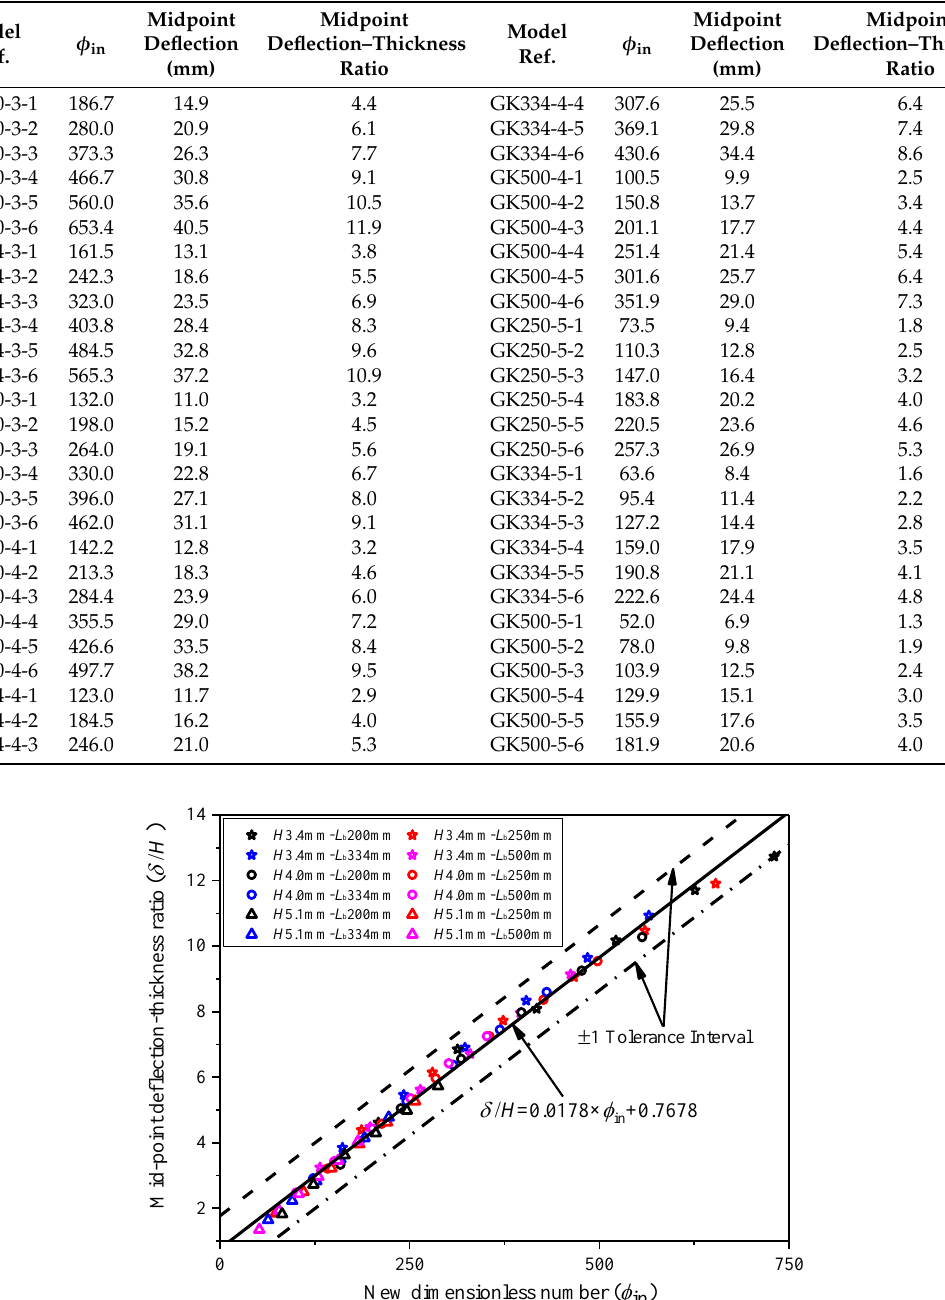
φ in  . Figure 9. The midpoint deflection–thickness ratio versus the new dimensionless number in